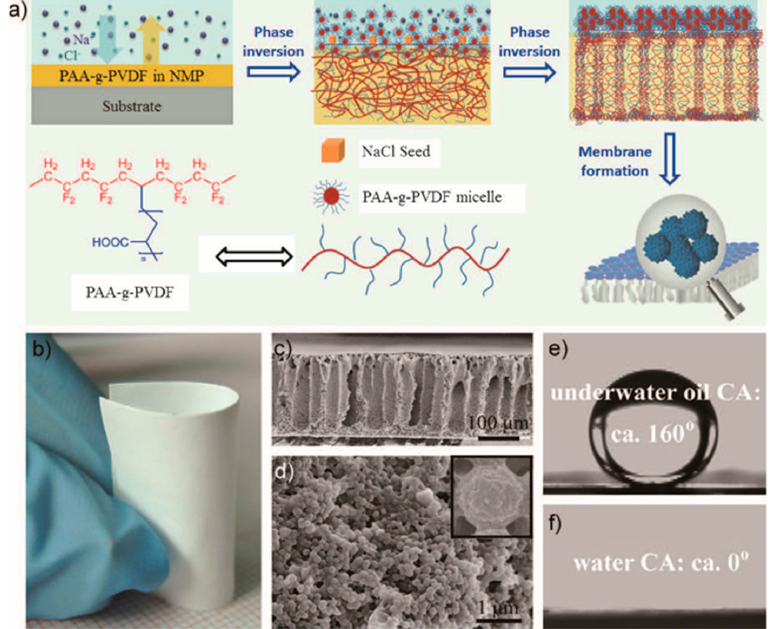
Figure 6. ( a ) Schematic of the preparation of PAA-g-PDVF membrane; ( b ) photograph of